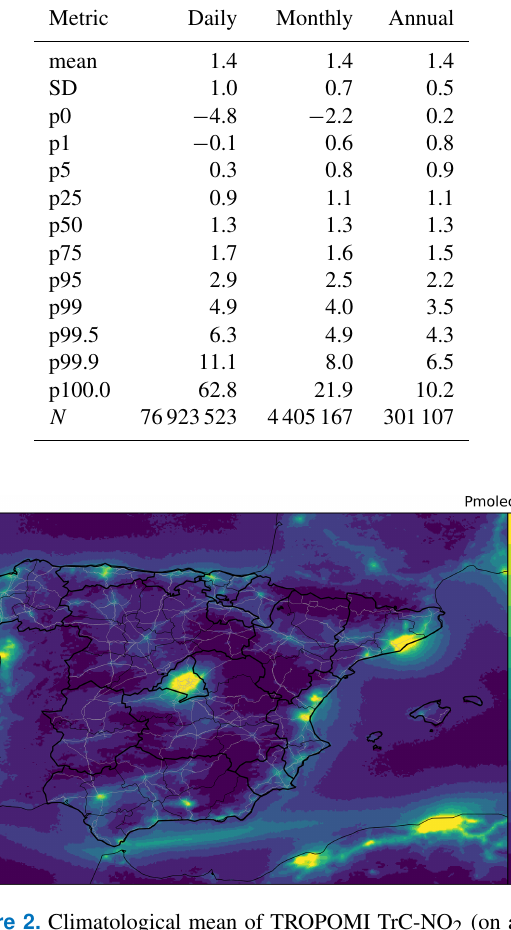
Figure 2. Climatological mean of TROPOMI TrC-NO 2 (on aver- age from May 2018 to December 2021). Black lines and grey lines correspond to administrative borders and Spanish major roads, re- spectively (sources: see Sect.